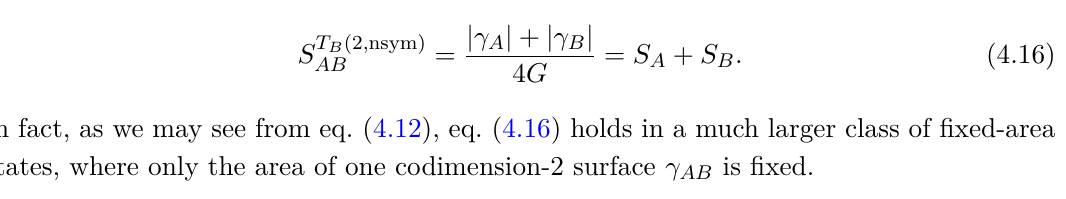
, and then the cut surfaces AB between copies 2 j − 1 and 2 AB